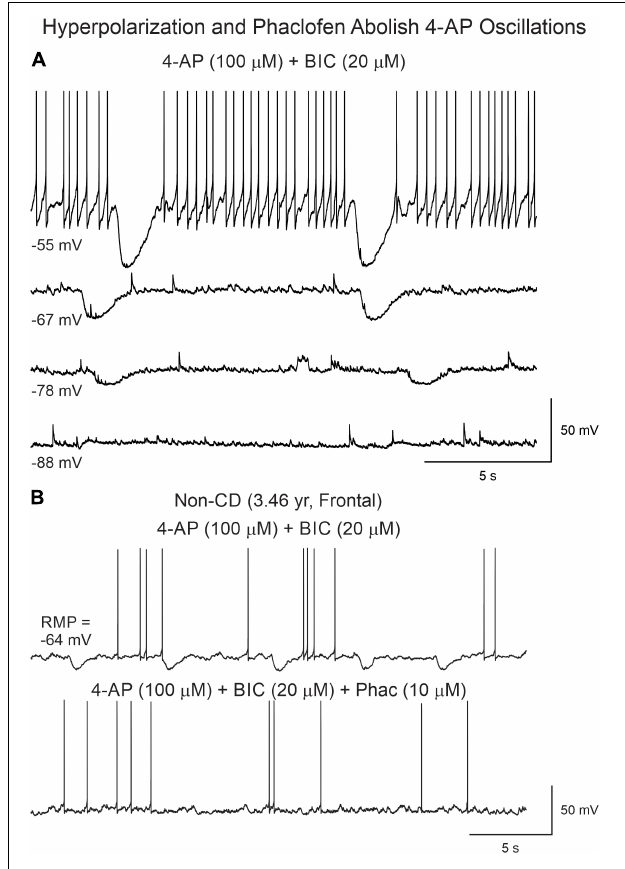
FIGURE 7 | Reversal potential of 4-AP oscillations after BIC. (A) With increasing membrane hyperpolarization, by injection of negative current, the amplitude of the oscillation was reduced and reversed around − 85 mV, suggesting involvement of K + conductances, as expected if GABA B receptors were activated. (B) Supporting this idea, addition of the GABA B receptor antagonist phaclofen eliminated the 4-AP oscillation.